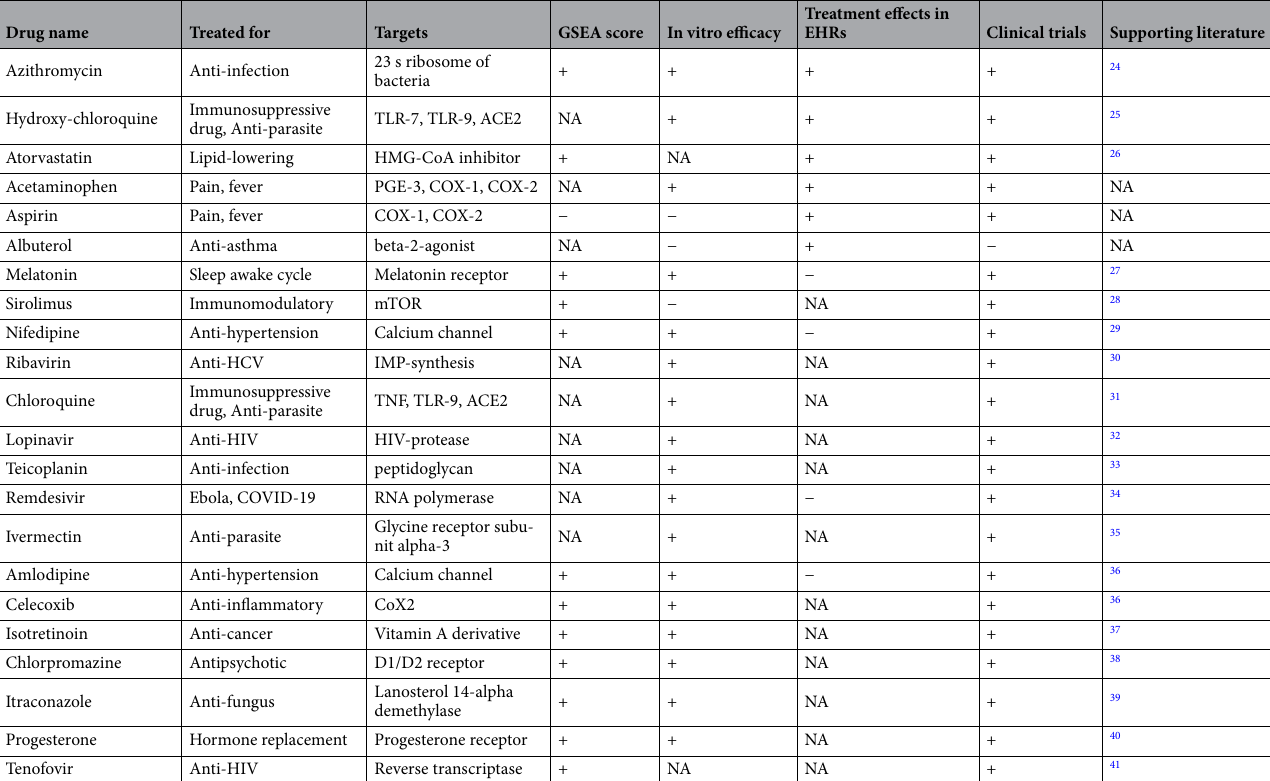
Table 3. Top 22 promising drugs with supporting evidence and literature. + positive evidence, − negative evidence, NA not investigated. Positive in vitro efficacy if there is at least one positive efficacy in the four different in vitro experiments. Full list in Table S4.